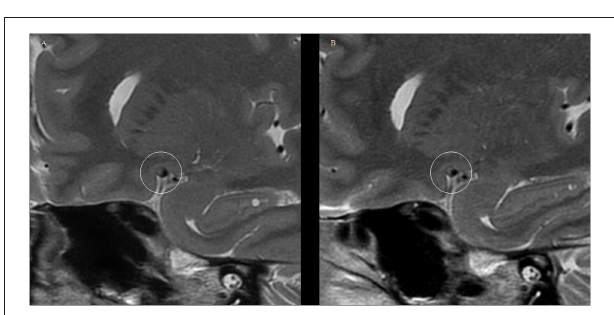
FIGURE 3 | VWMRI of plaque surface changes in the MCA of a patient after receiving 12 months of atorvastatin treatment. (A) 2D FSE T2WI at baseline level showing the rough surface of the MCA plaque. (B) 2D FSE T2WI at the 12-month follow-up time point shows a smooth and well-defined MCA plaque